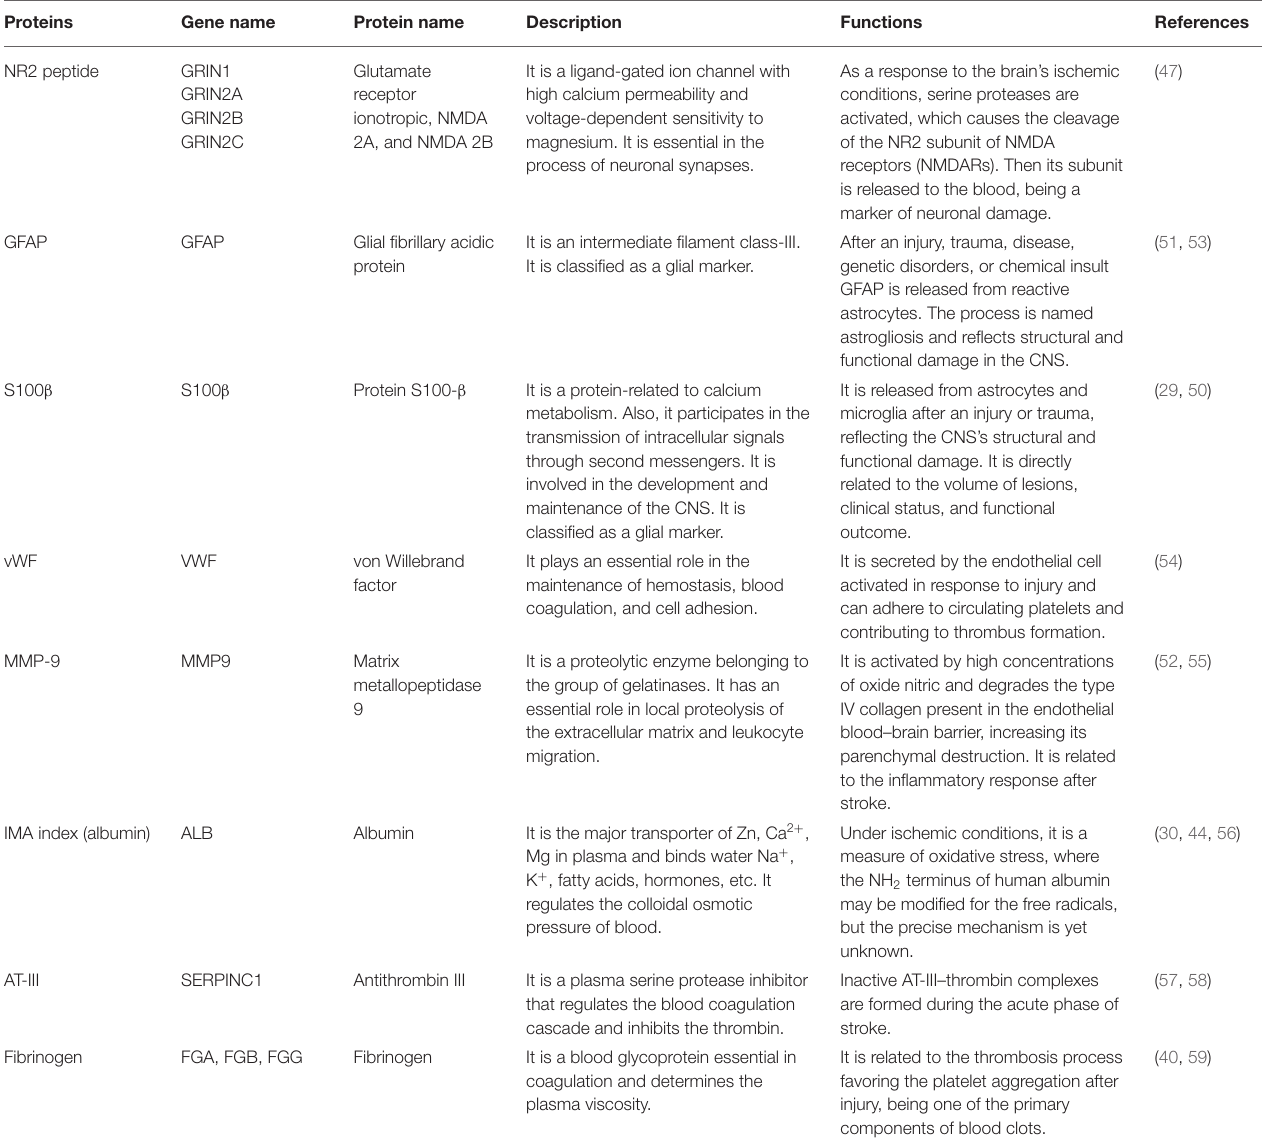
TABLE 3 | Biomarkers derived from the biomarker panel proposal and their possible role identified in